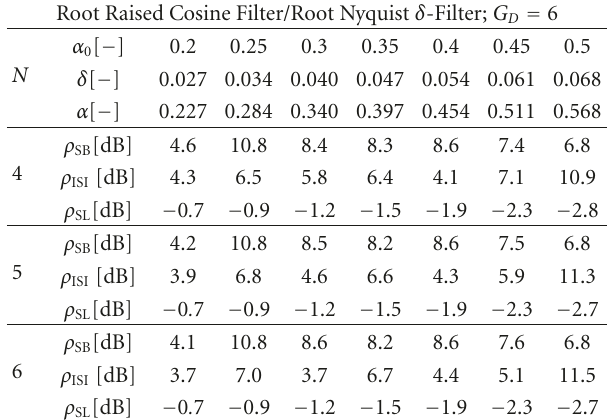
Table 2: Numerical values of ρ SB [dB], ρ ISI [dB], ρ SL [dB]. Square root RC filter versus square root Nyquist δ -filter. The group delay parameter of the filters is fixed G D = 6 and the oversampling factor N varies.